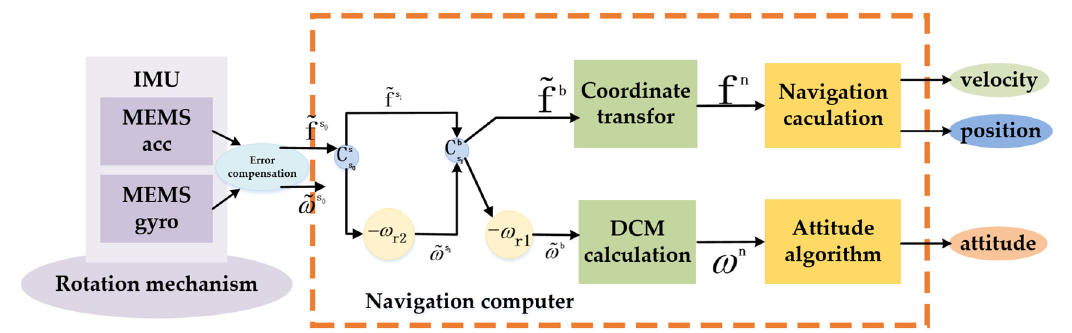
Figure 6. Compound rotation modulation navigation algorithm.